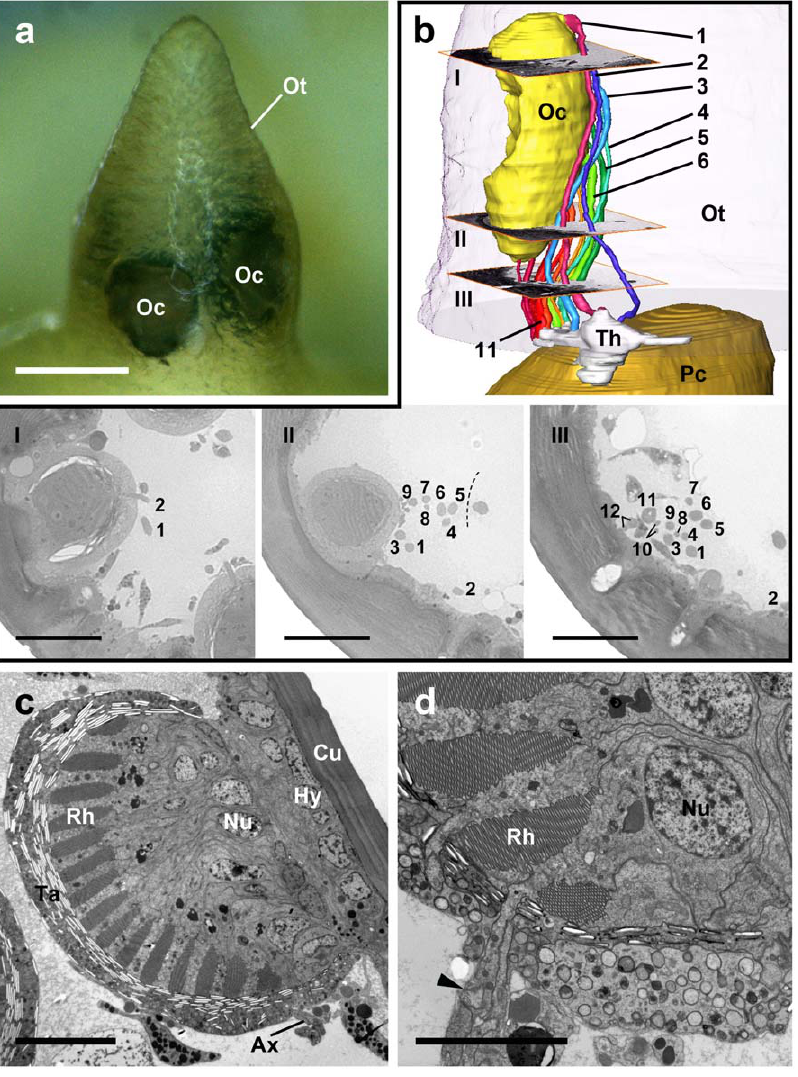
Figure 1. Periscope-like ocular tubercle with ocelli and nerve fibres to the protocerebrum. a , Light microscopic picture of the ocular tubercle (Ot) in Endeis spinosa showing two of the four ocelli (Oc). Bar 100 m m. b , 3D semithin serial reconstruction of nerve fibres projecting from left rostral ocellus to dorsolateral thickening distal to first neuropil ( Endeis spinosa ). Note retained relative positions of nerve fibres representing subsets of retinula cells (indicated by numbers). I–III: Three selected planes (Richardson staining; for position, see rendering at top right), showing profiles of groups of photoreceptor nerve fibres, originating from neighbouring r-cells, indicated by numbers. I, Frontal section from top quarter of eye. II, Frontal section from bottom quarter of eye. III, Frontal section through loose strand of nerve fibres just below eye. Bars 25 m m. Oc, ocelli; Ot, ocular tubercle; Pc, protocerebrum; Th, thickening. c , Transmission EM of a single ocellus in Achelia vulgaris showing the arrangement of the retinula cells. Ax, axon; Cu, cuticle; Hy, hypodermis; Nu, nucleus; Rh, rhabdom; Ta, tapetum. Bar 5 m m. d , Transmission EM of a retinula cell with a sequence from outside to inside of nucleus (Nu), rhabdom (Rh), and axon (arrowhead) demonstrating their ‘‘pseudoinverted’’ structure ( Achelia vulgaris ). Bar 10 m m.